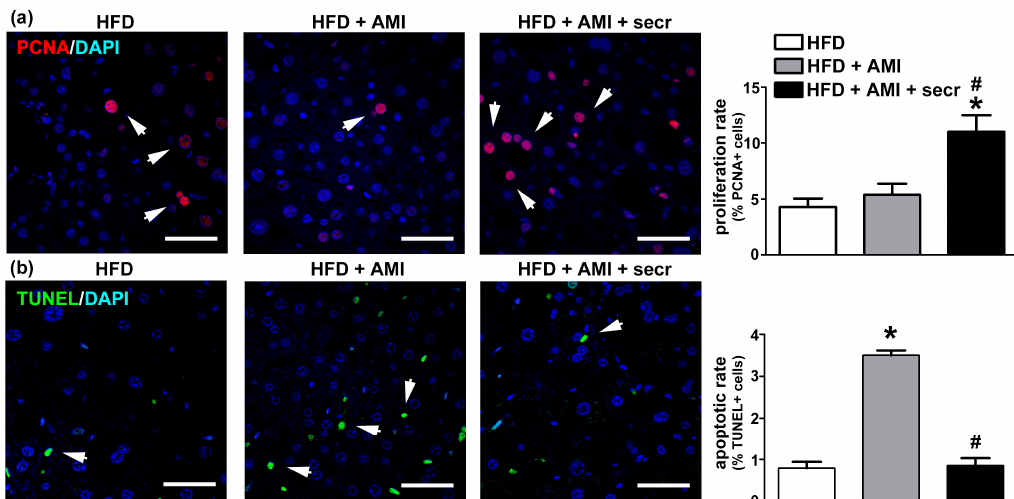
Figure 8. MSC secretome administration enhanced proliferation and inhibited apoptosis of hepatic cells after chronic exposure to AMI. Cell proliferation and apoptosis were analyzed in all experimental groups 24 h after the last administration of AMI. The effect of MSC secretome (secr) on cell proliferation was evaluated by PCNA immunoreactivity (Alexa Fluor 555, red), while cell apoptosis was determined by TUNEL staining (FITC, green). In both cases, nuclei were counterstained with DAPI (blue). Few PCNA (+) cells were seen in steatotic livers, regardless of whether the mice had been treated chronically with vehicle (control) or AMI, whereas in the group treated with MSC secretome significantly more PCNA (+) nuclei were observed. On the other hand, mice in the obese group exposed to AMI presented an increased basal apoptotic rate, whereas a significant reduction in TUNEL (+) nuclei was observed when MSC secretome was administered jointly with AMI. Representative micrographs of liver tissue in which hepatocyte proliferation was determined by ( a ) PCNA labeling or ( b ) TUNEL are shown (arrows). Scale bars represent 50 µm. Quantification of PCNA- and TUNEL-positive nuclei was carried out by digital image analysis. All data are presented as means ± SEM for 30 random fields per animal and six animals per group. * p < 0.05 vs. control HFD mice; # p < 0.05 vs. HFD+AMI mice.